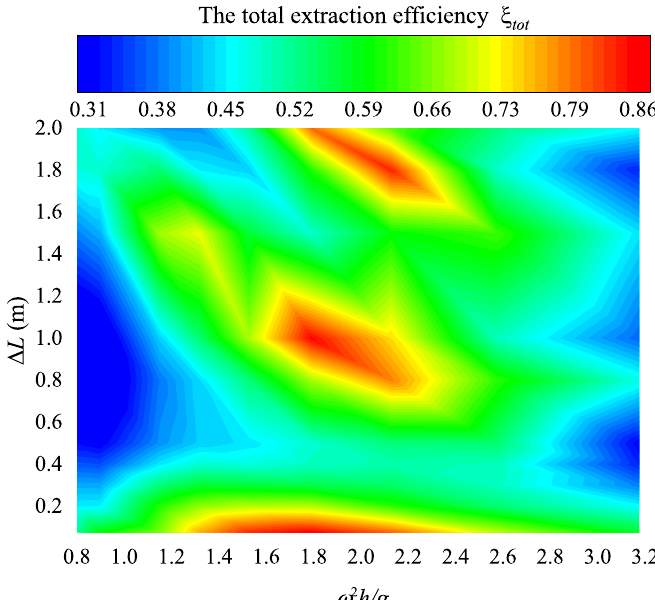
Figure 19. The contour of the total efficiency as a function of the gap ∆ L and the dimensionless frequency ω 2 h / g . In all cases, b 2 / b 1 = 2, d 1 = d 2 = d 3 = 0.05 m, and K =